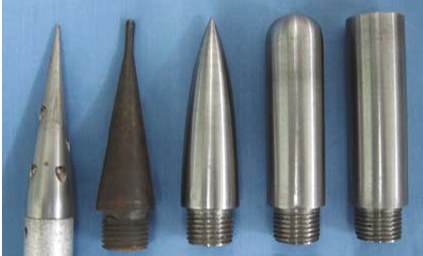
Figure 14: Several anchor tips with di ff erent shapes.